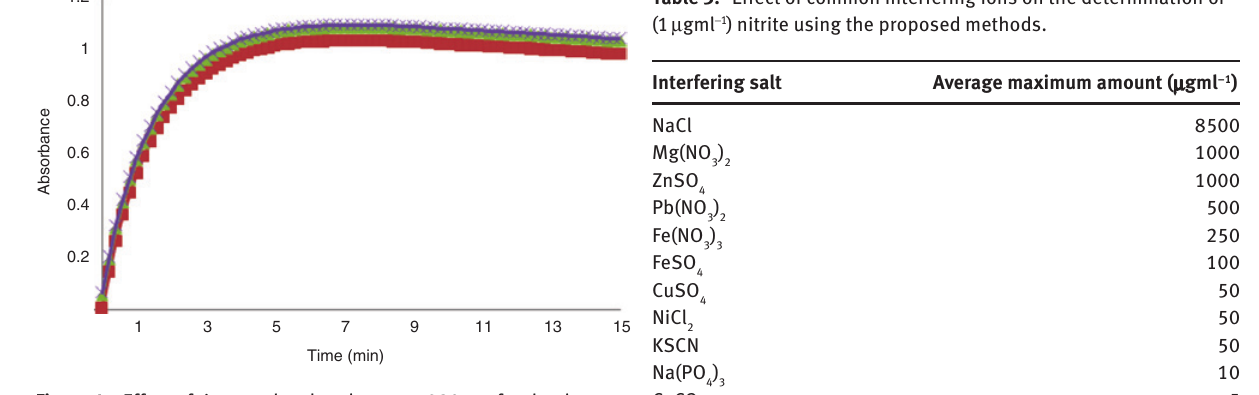
Figure 4: Effect of time on the absorbance at 380 nm for the three methods.